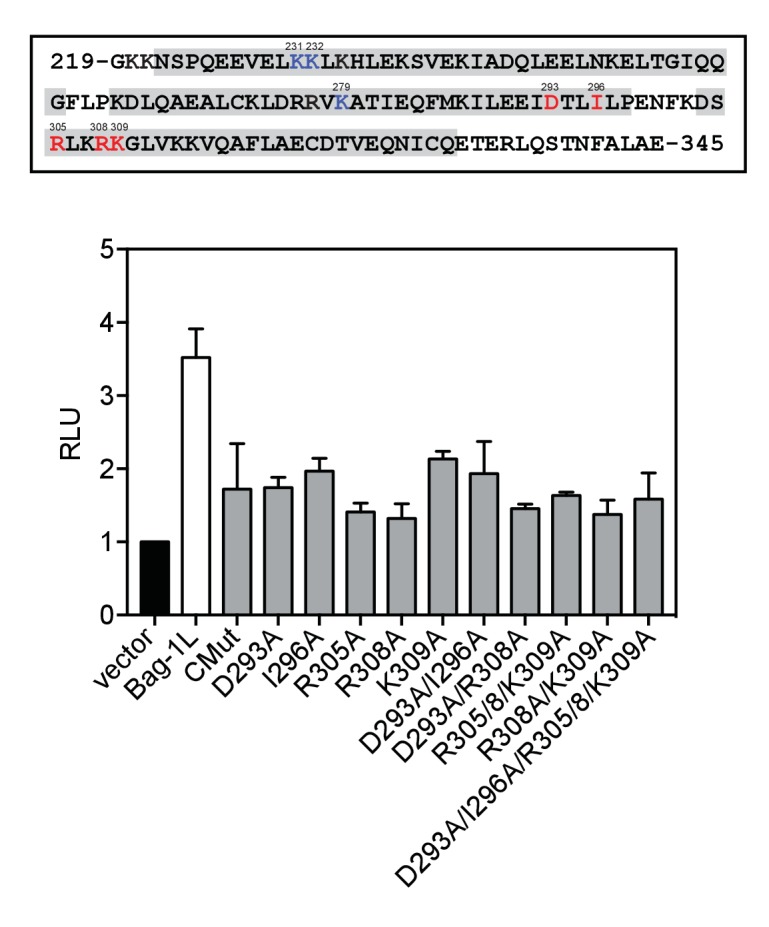
Conserved BAG domain mutations that inhibit the AR AF-1 transactivation.Top, amino acid sequence of the BAG domain of Bag-1L (residues 219–345) with evolutionarily conserved residues highlighted in red and CMut (K231A/K232A/K279A) shown in blue. Residues involved in α-helix formation are highlighted in grey. Bottom, MMTV luciferase promoter assay in HeLa cells with MMTV luciferase construct, TK Renilla luciferase and ARΔLBD (amino acids 1–682), plus the indicated BAG domain mutants. The results are the mean of three independent experiments ± SD.